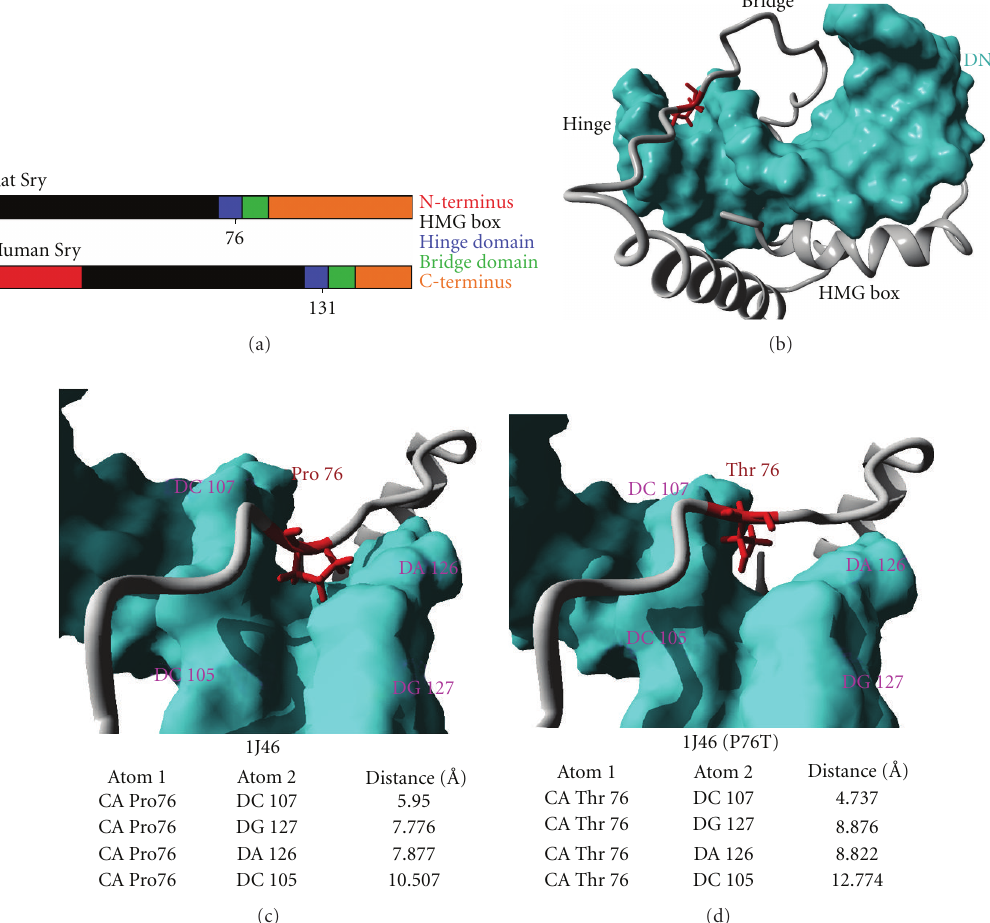
Figure 1: Modeling Sry variations of Sry1, Sry3, and hSRY. (a) Schematic of the rat Sry and human SRY proteins with amino acid 76 of rat (131 of human) shown. In red is the N-terminus, black the HMG box, blue the hinge domain, green the bridge domain, and orange the C-terminus. (b) Amino acid 76 (red) can be seen to interact with DNA (cyan) on modeled rat Sry1. (c) 1j46 (human SRY bound to DNA) was energy-minimized and the distances of the carbon alpha of the proline, amino acid at 76 (131), were measured from four di ff erent phosphates of DNA (DC 105, DC 107, DG 127, and DA 126). (d) 1j46 (P76T), in which the proline was substituted with a threonine, was energy-minimized and